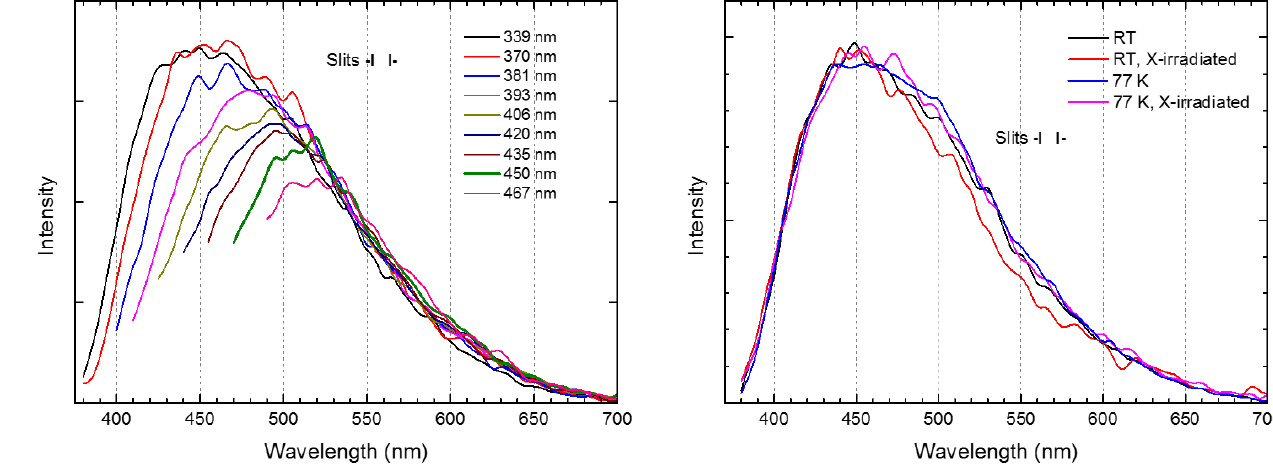
Fig. 6. Fluorescence spectra of urine fraction powder at room temperature (RT) and 77 K of a sample before and after irra- diation by X-rays at RT to the dose of 57.5kGy. An average spectral width of the monochromator slits is shown by